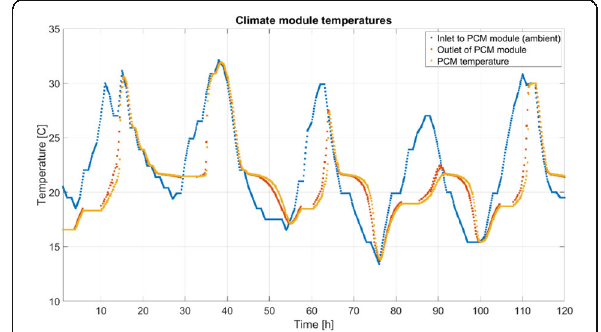
Fig. 6 (Abstract P7). PCM module inlet and outlet air temperatures along with PCM temperature.